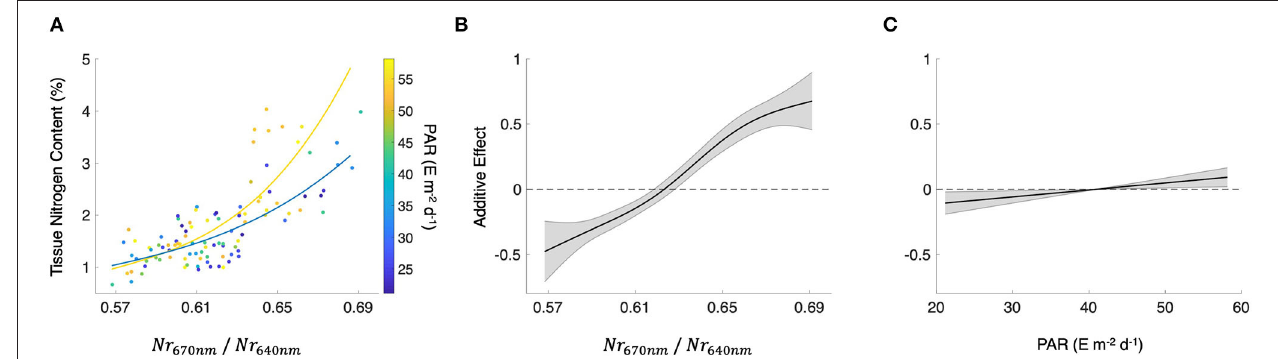
FIGURE 3 | (A) Scatterplot of the spectral band ratio of normalized reflectance for bands centered at 670 and 640nm ( Nr 670nm / Nr 640nm ) and tissue nitrogen content. Colored lines represent best fit lines between Nr 670nm / Nr 640nm and tissue nitrogen content in the high light season (yellow; April–September) and low light season (blue; October–March). Mean photosynthetically active radiation (PAR) for 30 days prior to the sampling date. (B) The additive effect of Nr 670nm / Nr 640nm on tissue nitrogen content and (C) the additive effect of PAR on tissue nitrogen content produced using a generalized additive model estimating tissue nitrogen content from both Nr 670nm / Nr 640nm and PAR. Black lines show the mean relationship and shaded gray areas show the standard